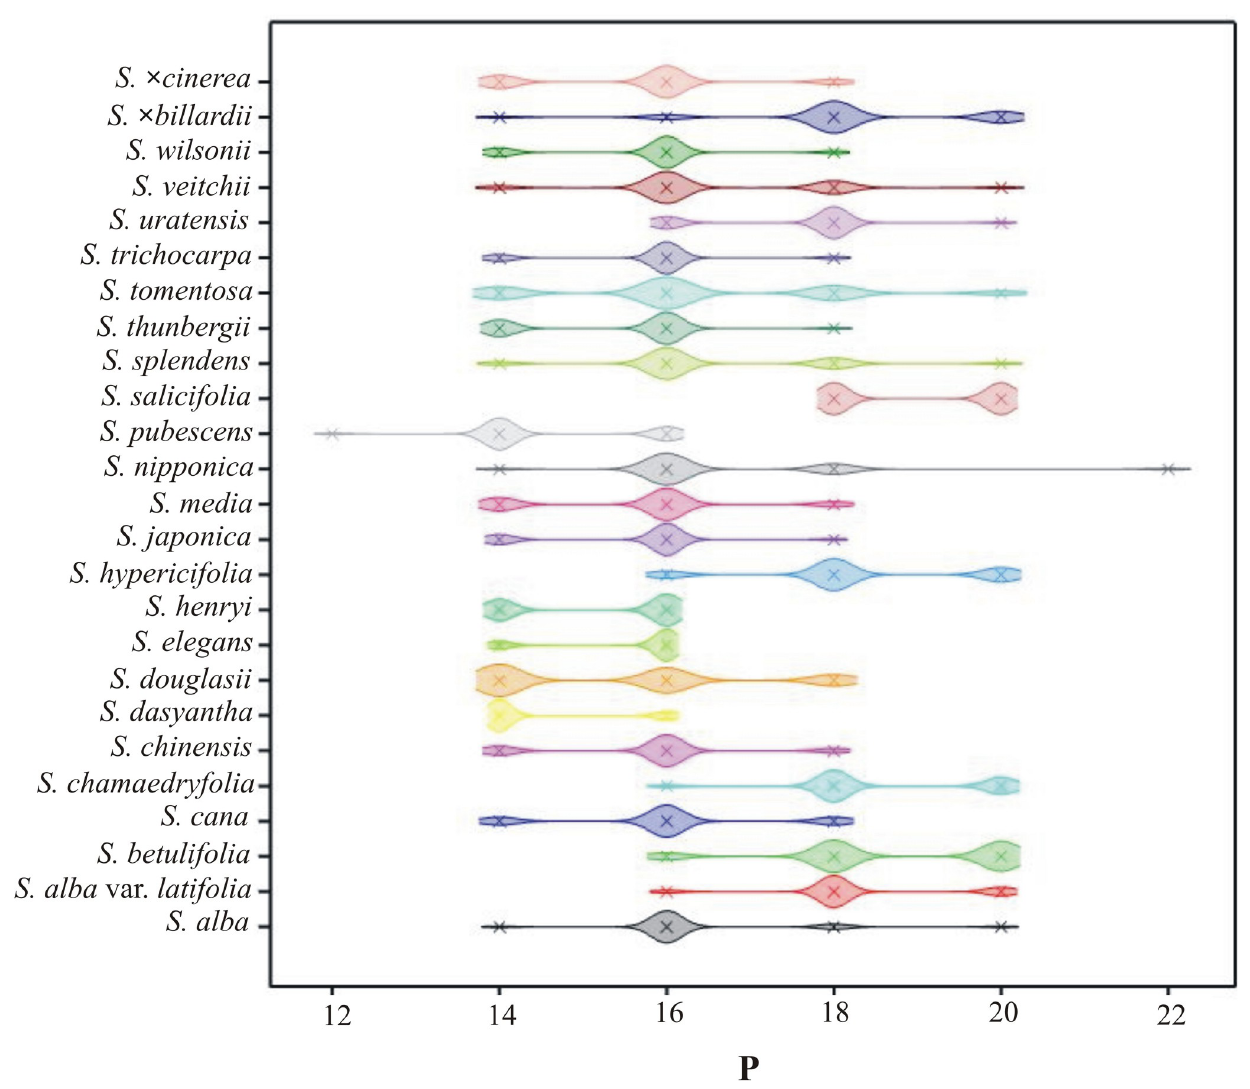
Fig 6. The density plot of P by Spiraea